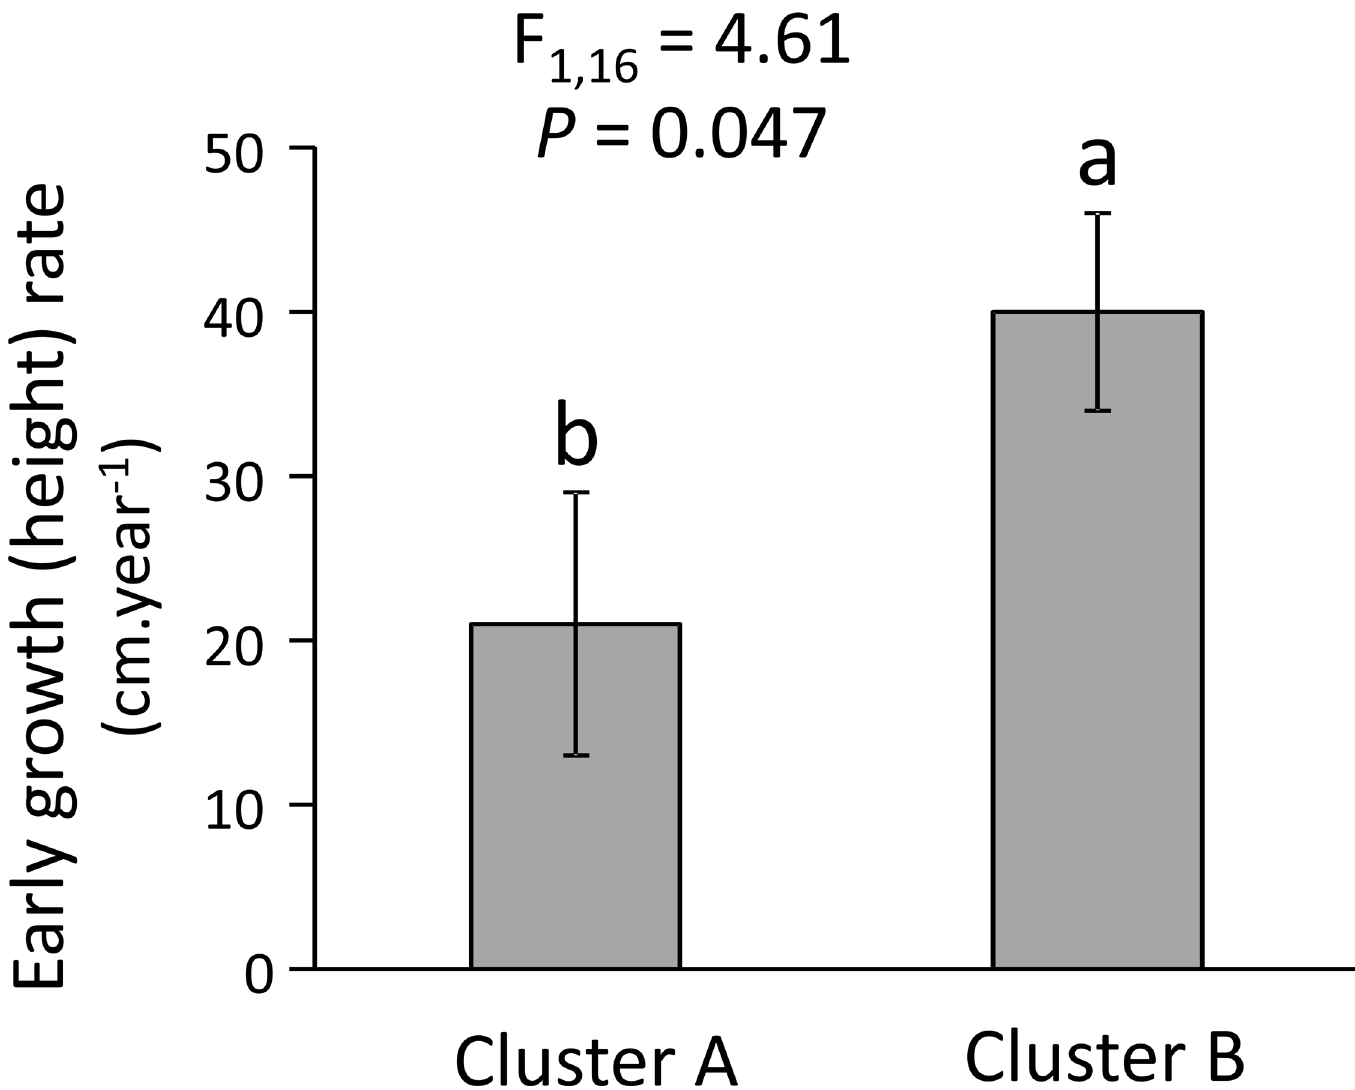
Fig 3. Differences in early plant growth (height) rate of 18 conifer species between the two defensive clusters. F and P-values of the effect of cluster after controlling for phylogeny using PGLS are shown. Bars are least square means ± s.e.m. (N = 9 species). Different letters indicate significant differences between defensive trait